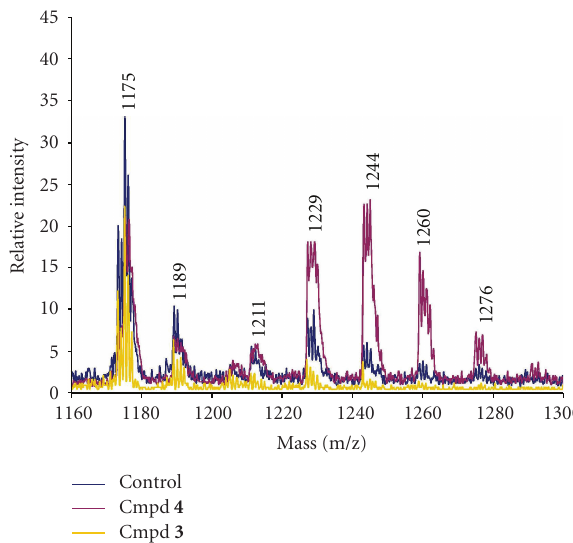
Figure 2: Mass spectrum of MEMEs from M. tuberculosis H37Rv cultures treated with ethoxycubebin ( 3 ) and AC451 ( 4 ) at 24